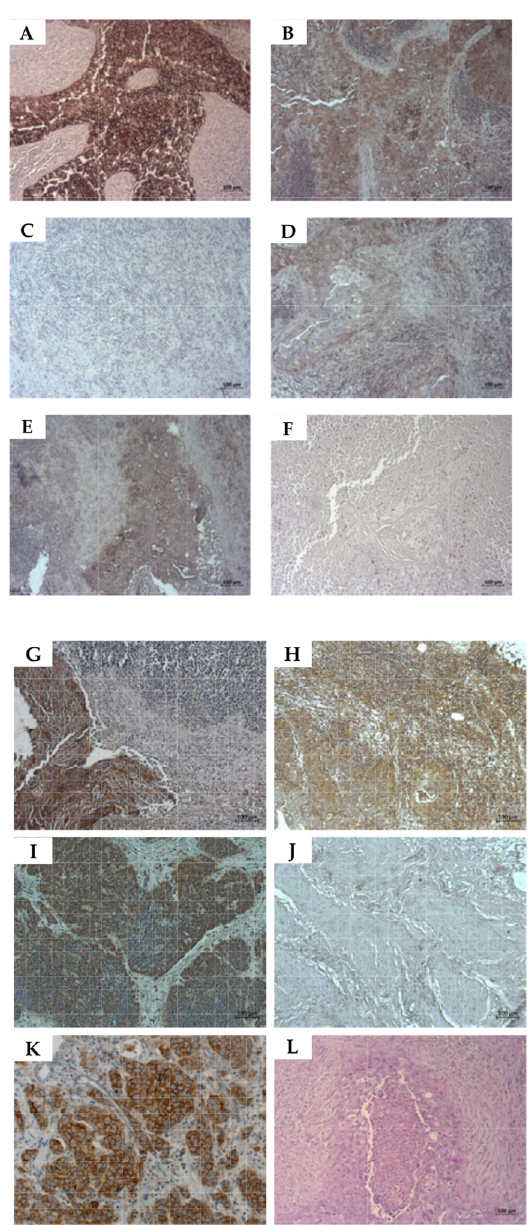
Figure 8. Expression of bladder cancer stem cell markers in tissue samples from bladder cancer patients. Paraffin sections were generated from metastases in lymph nodes ( A – F ) and from bladder tissue samples ( G – L ) of bladder cancer patients, and stained with antibodies AE1/AE3 ( A , G ), anti- vimentin ( B , H ), anti-CD24 ( C , I ), anti-CD44 ( D , J ), and anti CD276 antibodies ( E , K ), respectively. Omitting the primary antibodies served as controls ( F , L ). The samples were counterstained by HE. Expression of AE1/AE3, vimentin, and CD276 was recorded in both lymph node metastases and bladder cancer tissue sections. CD24 was not detected in any lymph node sample, but in bladder tissue. CD44 positive cells were seen in each lymph node sample investigated, while in the bladder cancer samples only a few cells were positive. Size bars indicate 100 µ